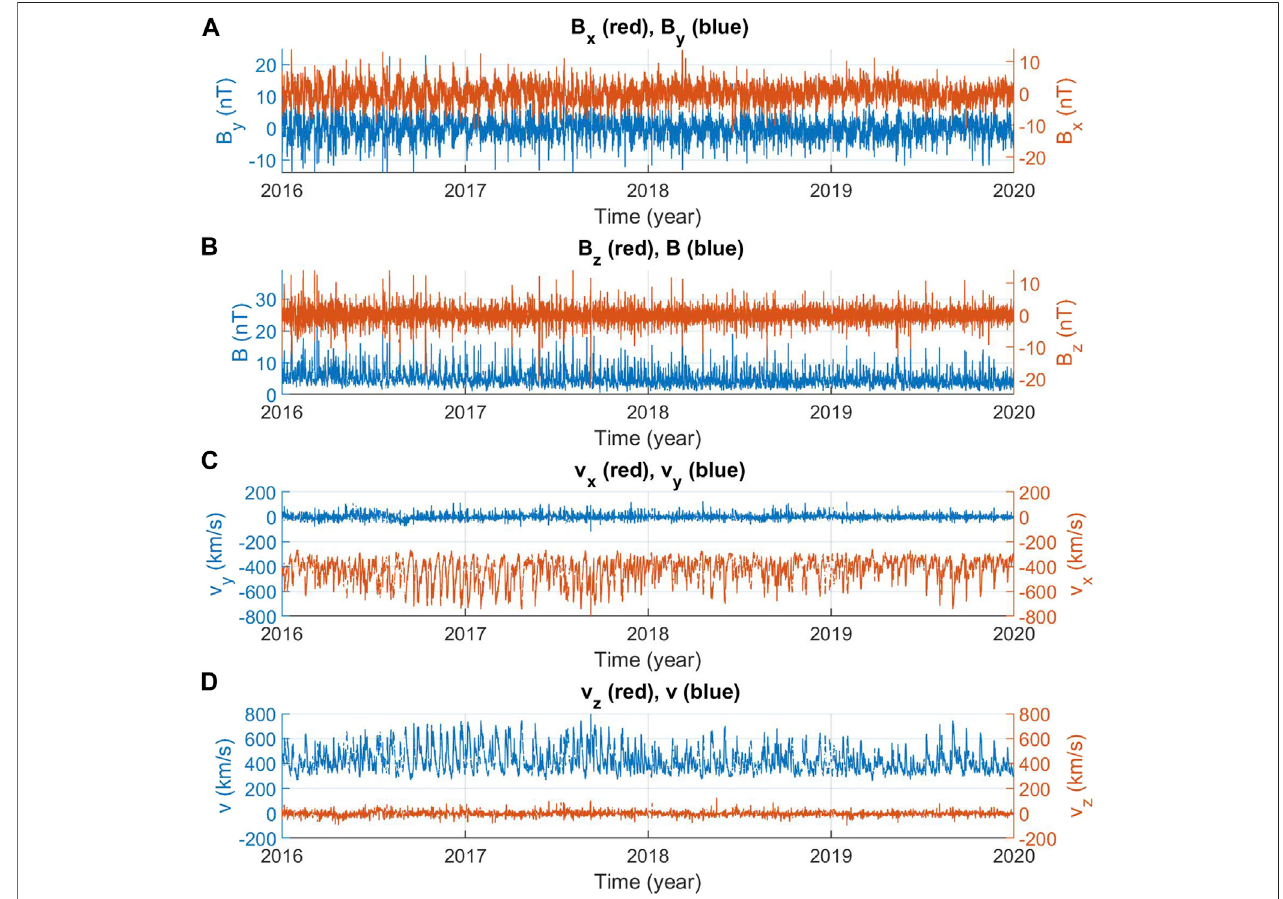
FIGURE 2 | Components of the HMF (A, B) and components of SW velocity (C, D) in GSE coordinates.